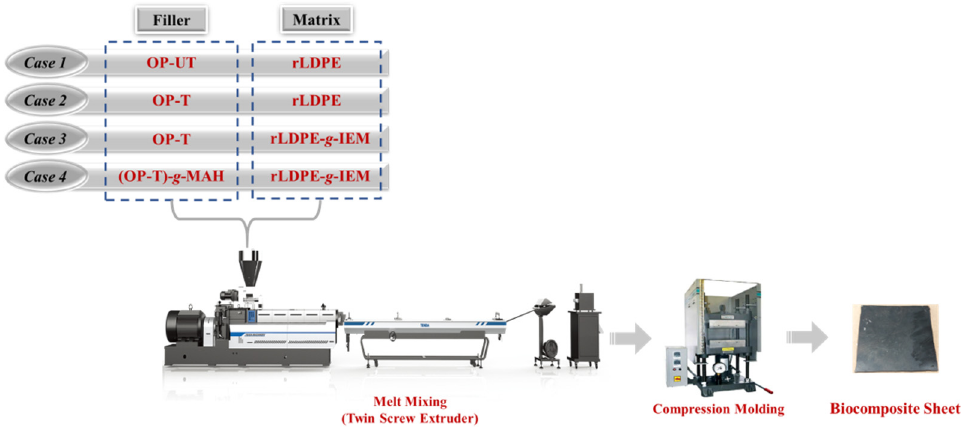
Figure 1. Graphical demonstration of classifications and production of developed biocomposites.